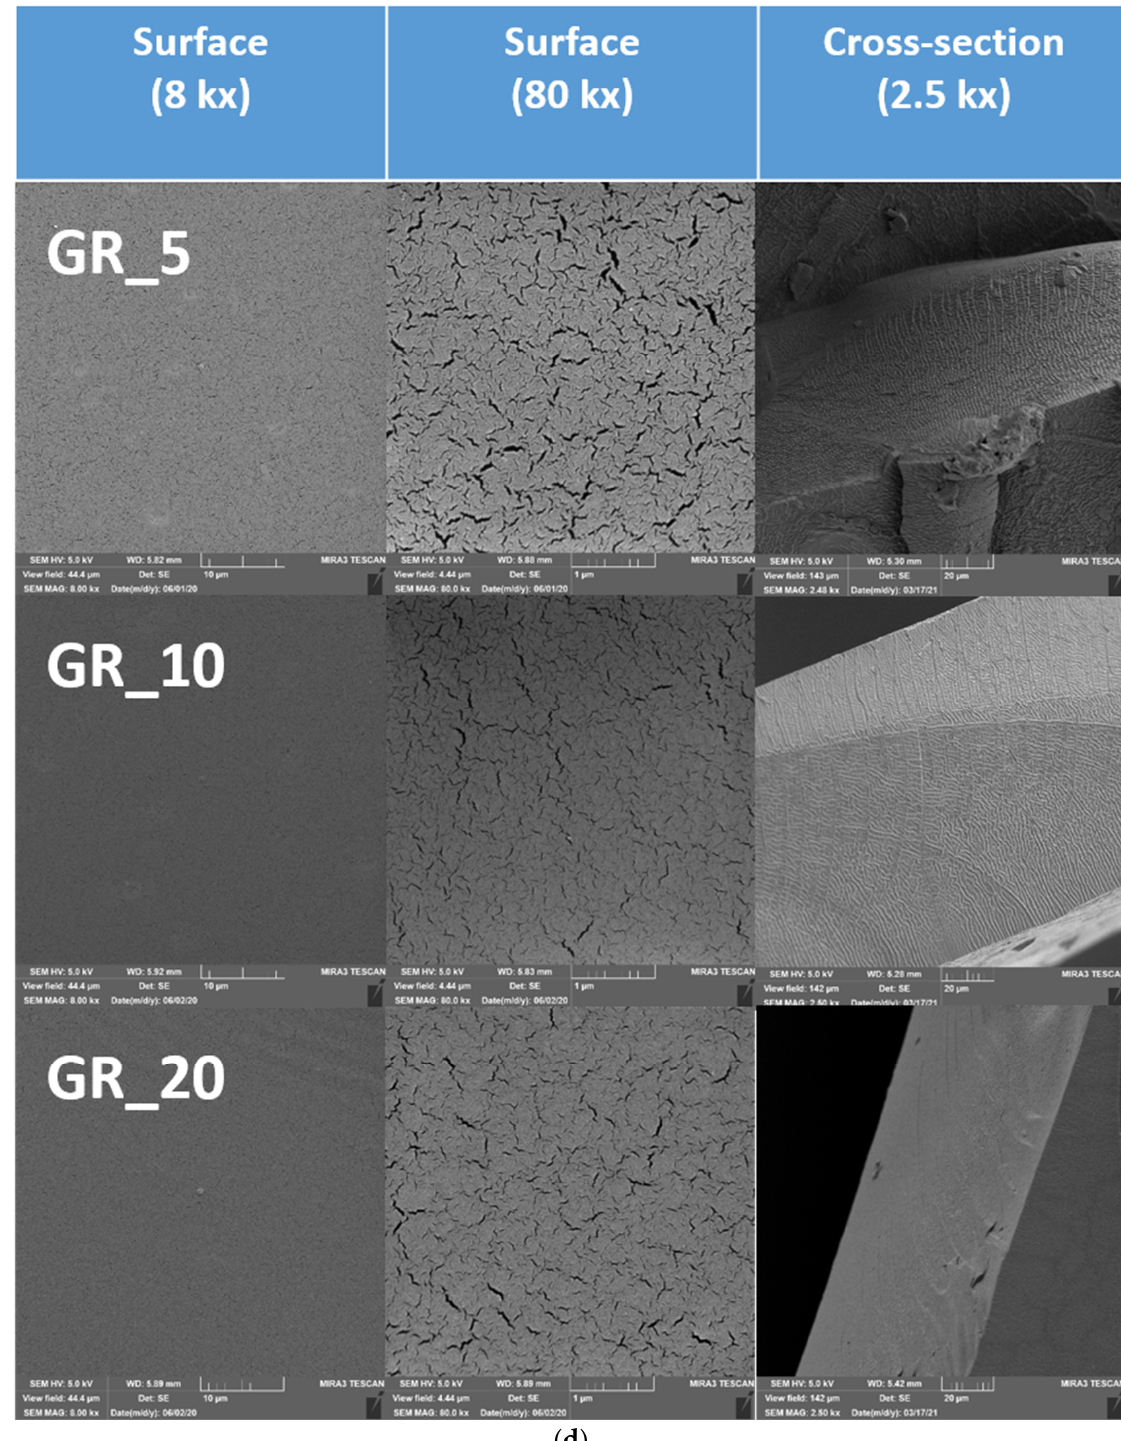
Figure 5. SEM images of edible coatings: surface images and cross-sections. ( a ) Ctrl, control = edible coating without added extract. ( b ) PA_5, edible coating with 5% of parsley extract; PA_10, edible coating with 10% of parsley extract; PA_20, edible coating with 20% of parsley extract. ( c ) BL_5, edible coating with 5% of blueberry extract; BL_10, edible coating with 10% of blueberry extract; BL_20, edible coating with 20% of blueberry extract. ( d ) GR_5, edible coating with 5% of red grape extract; GR_10, edible coating with 10% of red grape extract; GR_20, edible coating with 20% of red grape extract. Figure 6 documents the average size of the cracks in the surface of the formed gel. Figure 7 documents the distance between the cracks.